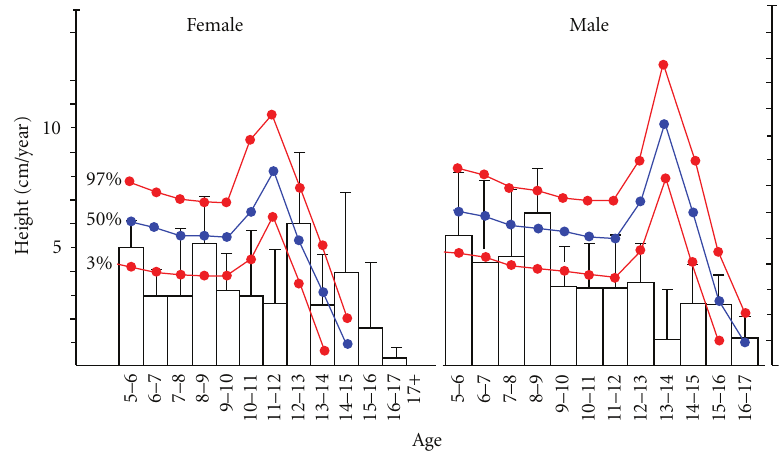
Figure 1: Average growth of thalassemic patients.